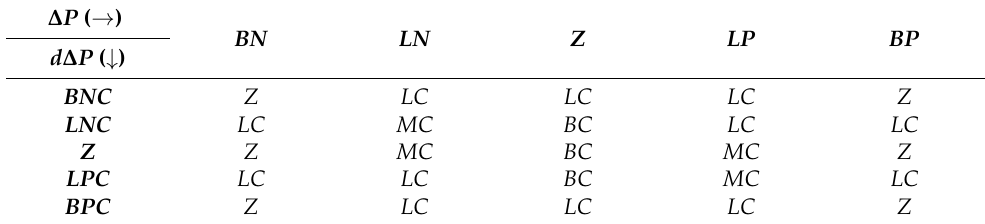
Table 1. Established fuzzy rules for frequency droop gain control.